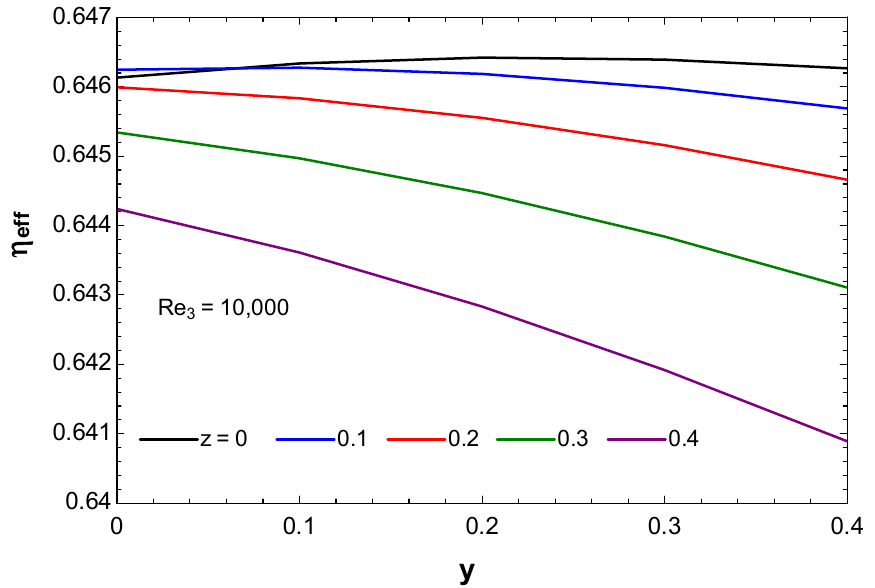
Figure 7. Effect of airflow ratios on thermohydraulic efficiency.